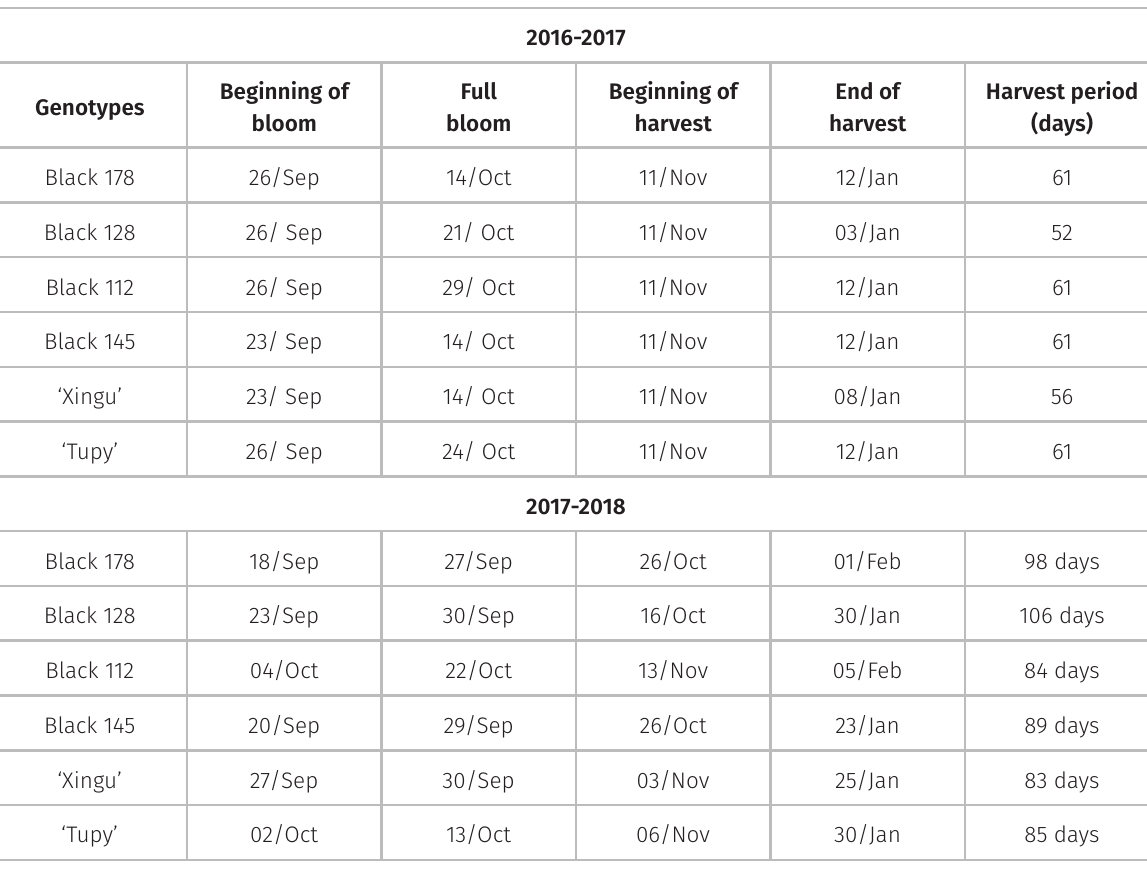
Table I. Phenological characteristics of six blackberry genotypes in an organic production system in 2016-2017 and 2017-2018. Pelotas, RS, Brazil,